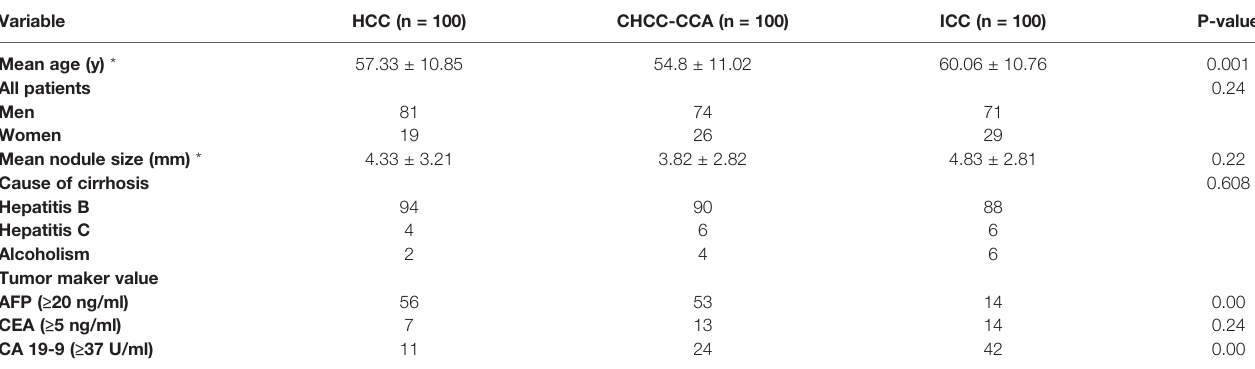
TABLE 1 | Clinical and pathological characteristics of study